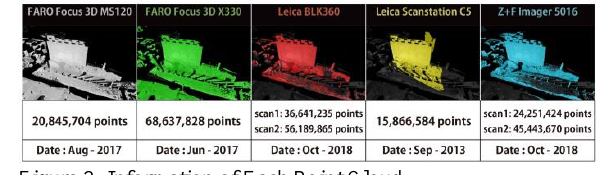
Figure 2: Information of Each Point Cloud